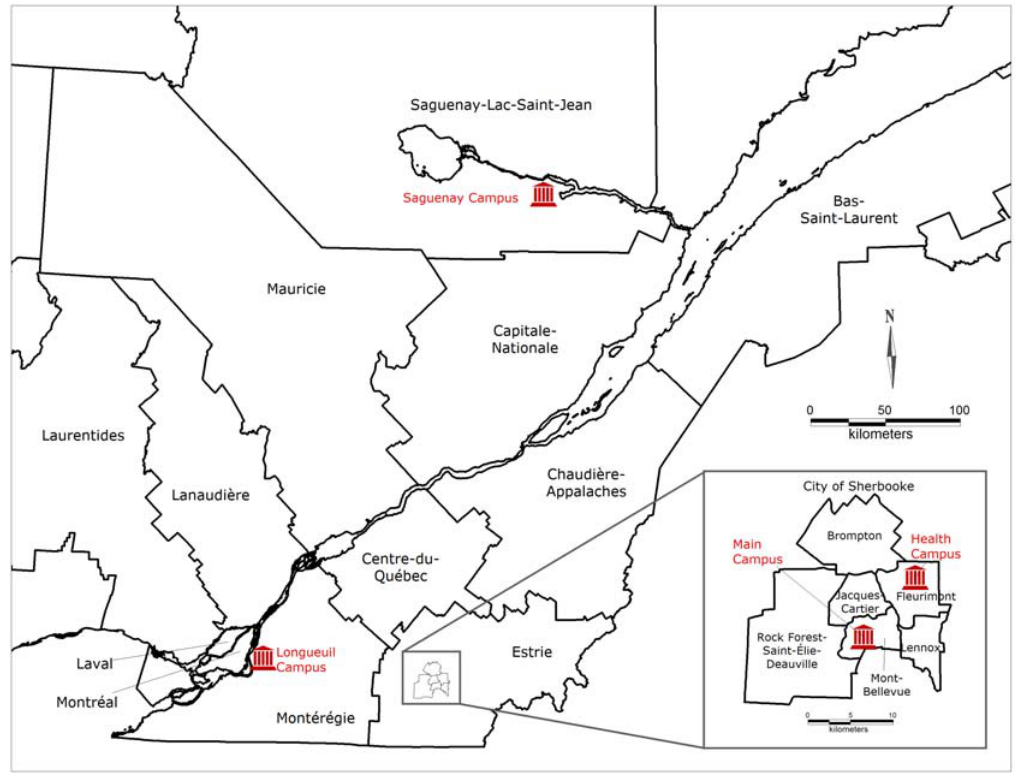
Figure 1. Geographic distribution of the Université de Sherbrooke campuses. Map of Quebec administrative regions with a zoom on the city of Sherbrooke; campuses are indicated by red symbols.